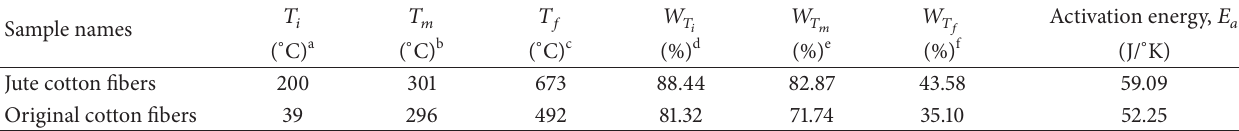
Table 1: Thermal characteristics of jute cotton fibers and original cotton fibers.